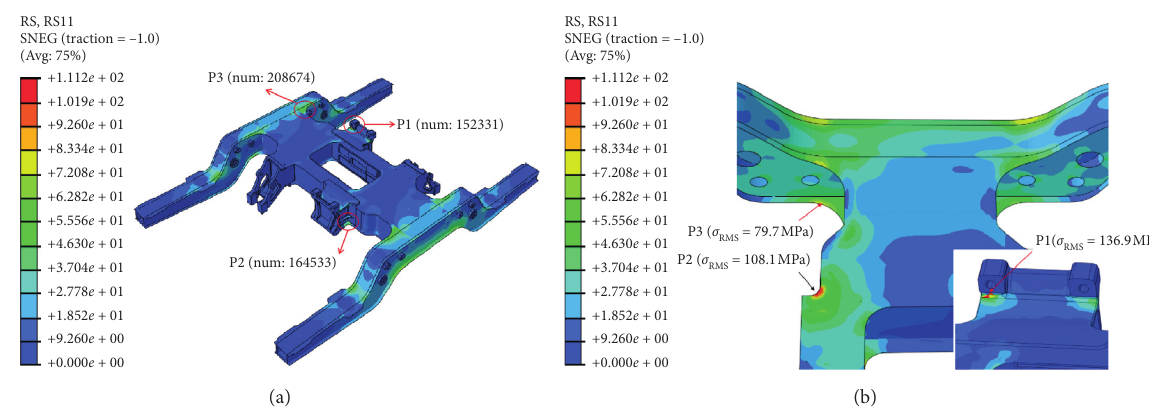
Figure 9: (a) RMS stress cloud diagram for the whole bogie frame (MPa). (b) RMS stress cloud diagram for the local part